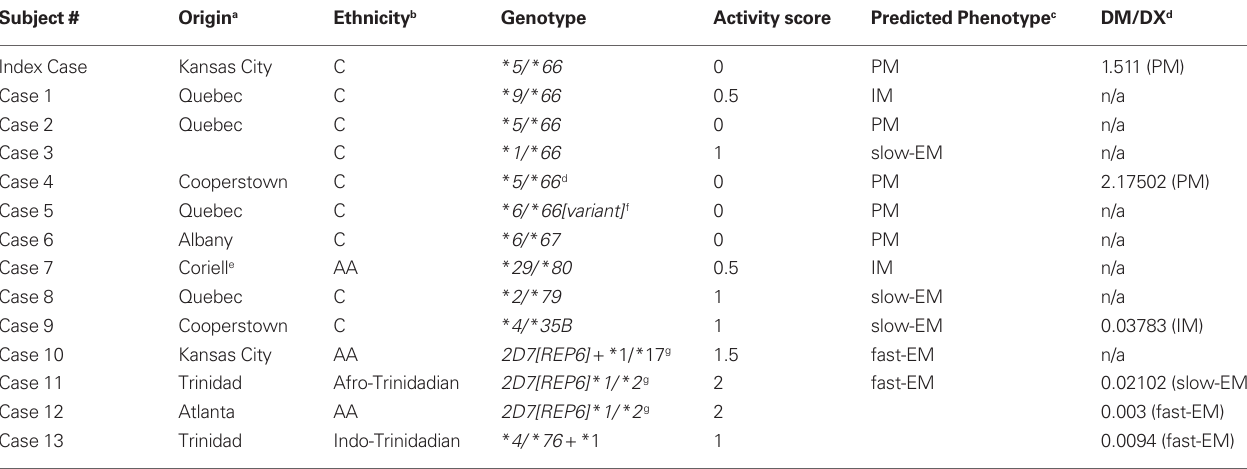
Table 1 | Summary of cases.